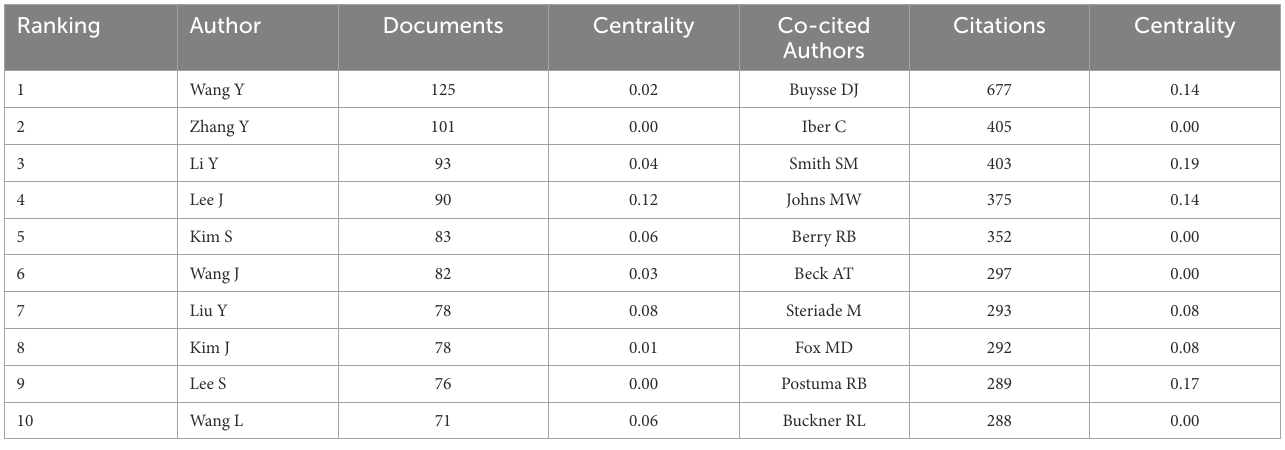
TABLE 2 Top 10 authors and co-cited authors.